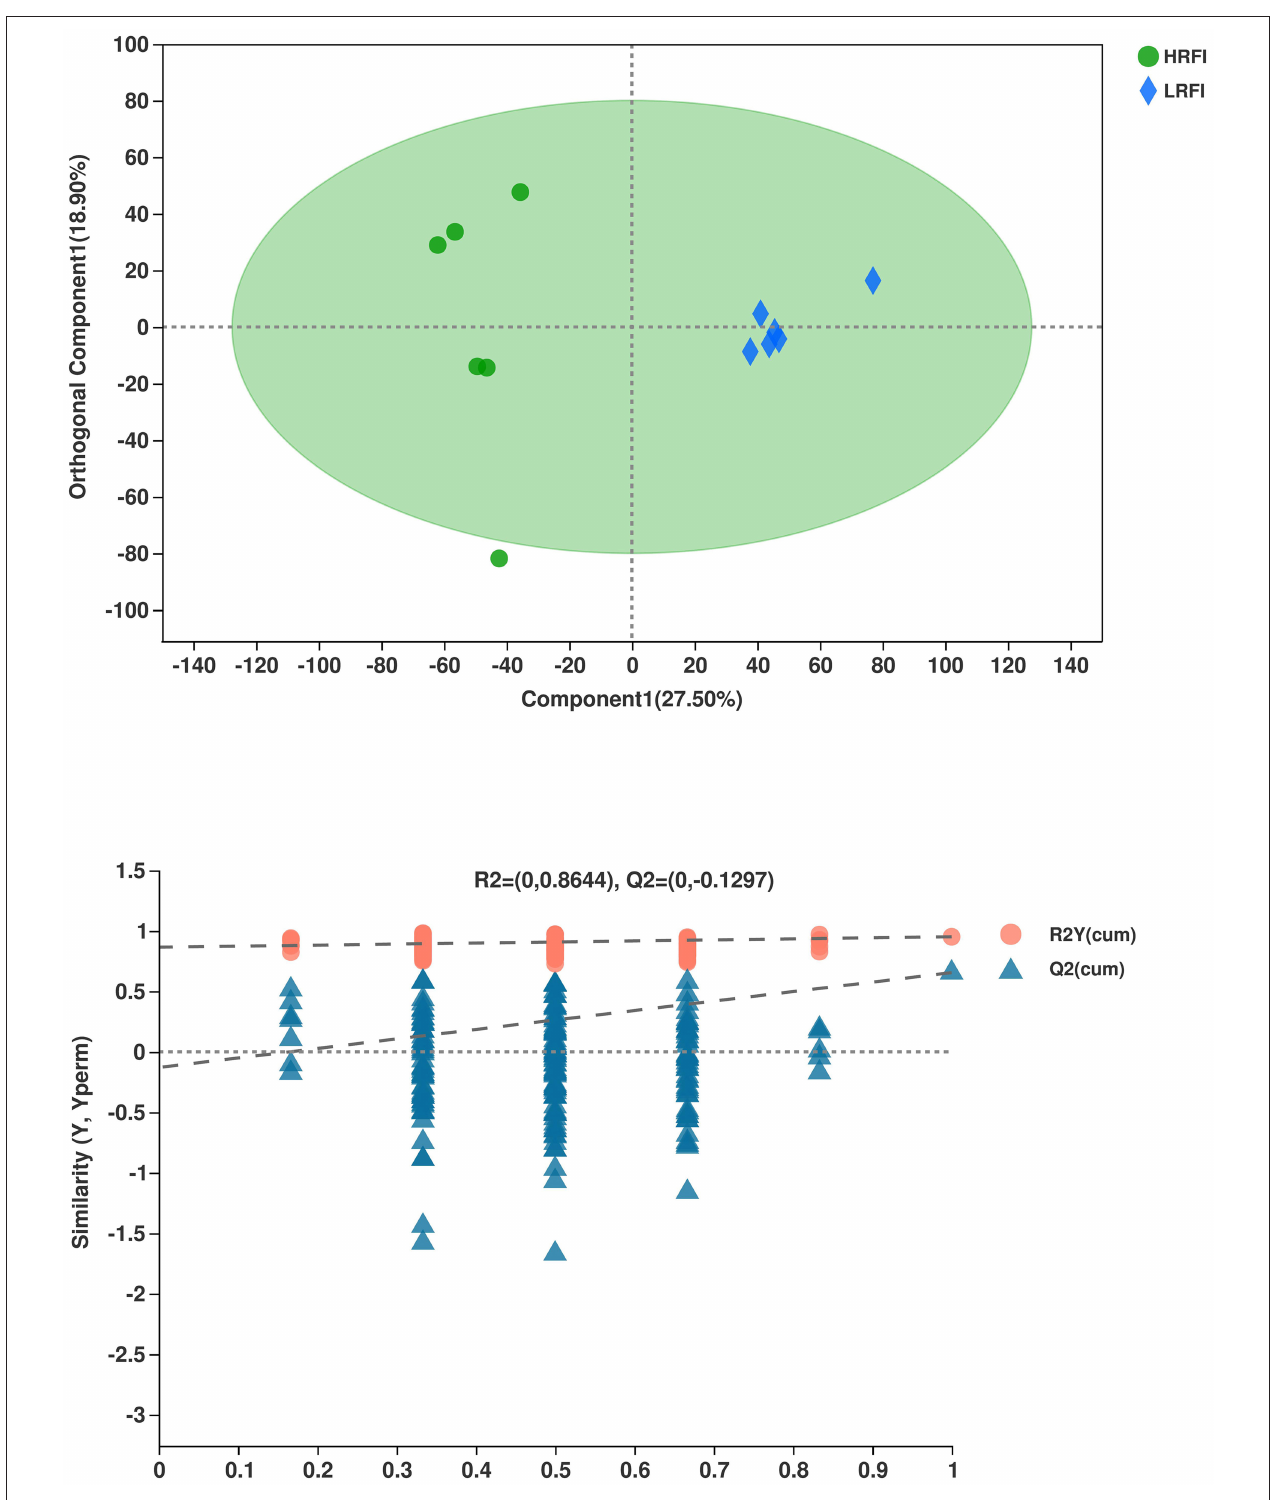
FIGURE 3 | The orthogonal partial least squares discriminant analysis (OPLS-DA) plot of rumen metabolites in comparisons of the HRFI and LRFI groups.